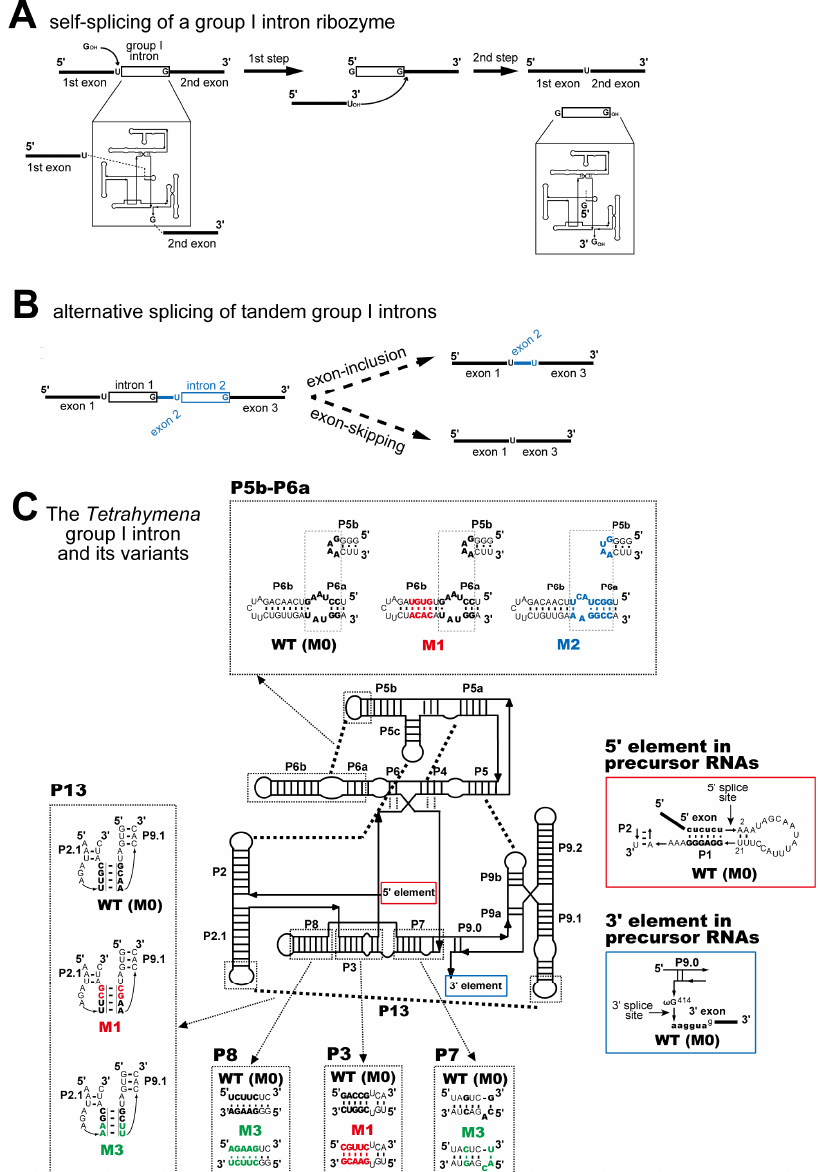
Figure 1. Self-splicing, alternative splicing, and secondary structures of group I intron ribozymes. ( A ) Schematic representation of self-splicing of a single group I intron ribozyme. The 5′ exon (1st exon) and 3′ exon (2nd exon) are shown as black lines. A group I intron ribozyme is shown as a thick white line. The last nucleotides of the 1st exon (U) and the intron (G) are shown. Schematic secondary structures of group I introns in the precursor form (left) and the excised form (right) are shown in boxes with solid lines. ( B ) Schematic representation of alternative splicing of two group I introns aligned in tandem with a short exon (exon 2). Exon 2 was present in exon-inclusion splicing and absent in exon-skipping splicing. ( C ) Secondary structures of the WT Tetrahymena group I ribozyme (WT or M0) and its variants (M1, M2, and M3). Colored nucleotides (red, blue, and green) in dotted boxes indicate the sequences of M1, M2, and M3, respectively. The 5 (cid:48) and 3 (cid:48) elements of the WT intron ribozyme are shown in red and blue boxes, respectively. Three thick broken lines indicate tertiary base pair interactions (P13 and P14) and a loop–receptor interaction (P5b–P6a). P13 and P5b–P6a interactions were modified to generate M1, M2, and M3